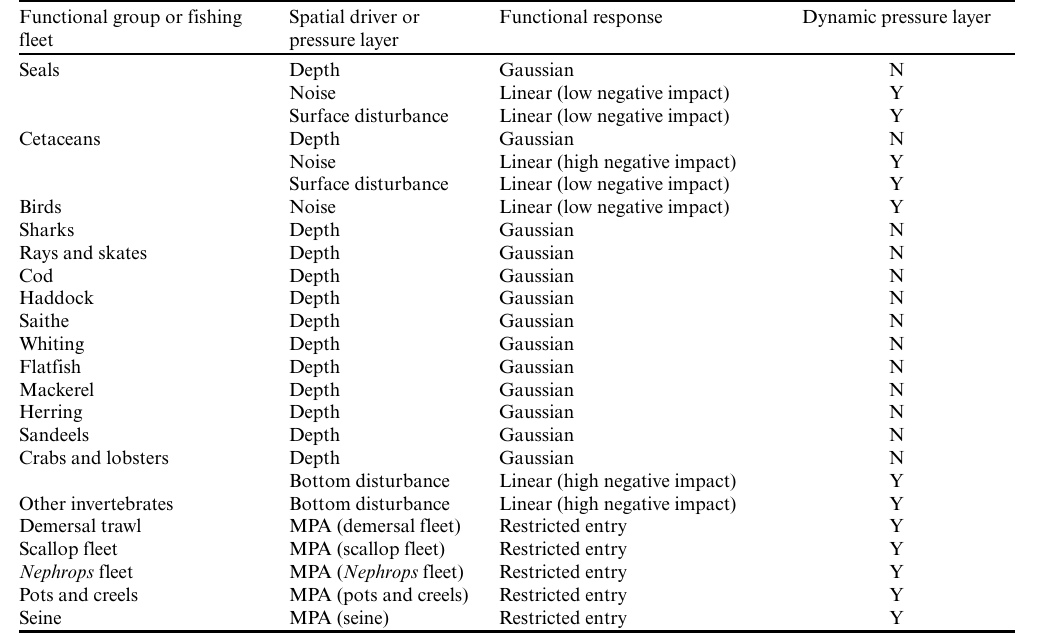
Table 8. Spatial pressures and drivers applied to functional groups and fishing fleets in the marine spatial planning challenge Clyde Sea Ecospace model. MPA = marine protected